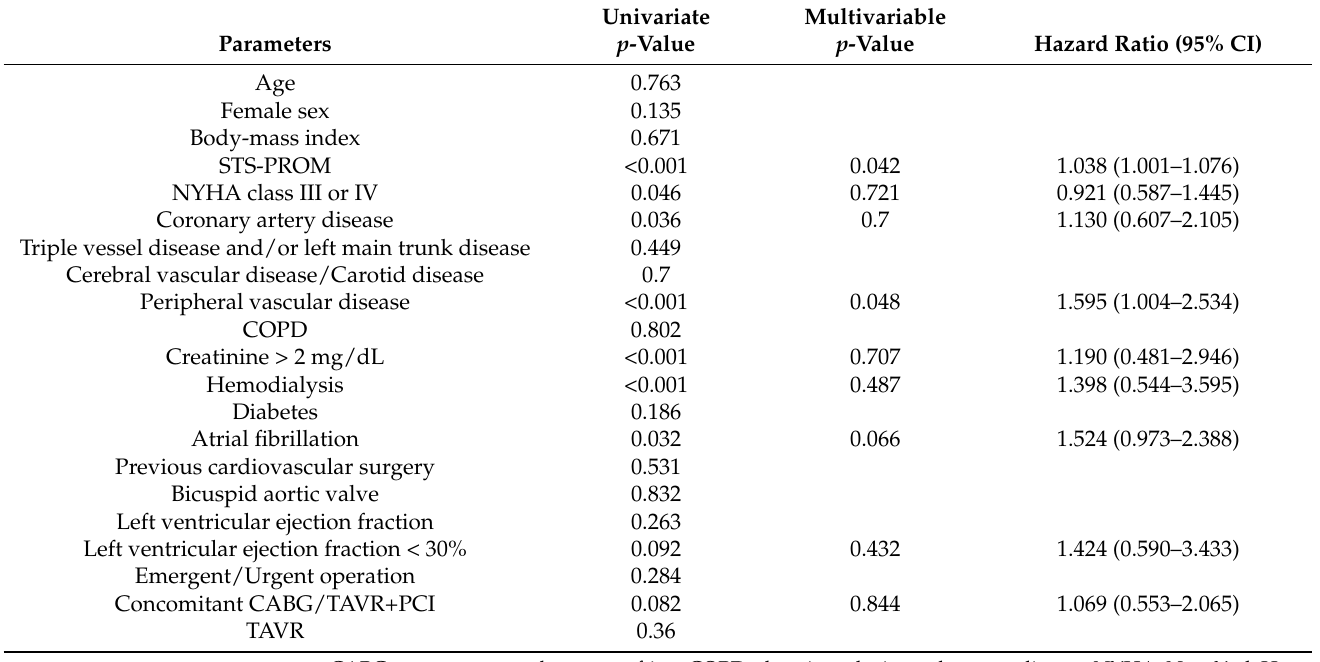
Table 4. Preoperative risk factors for the primary endpoint (Cox hazard model).